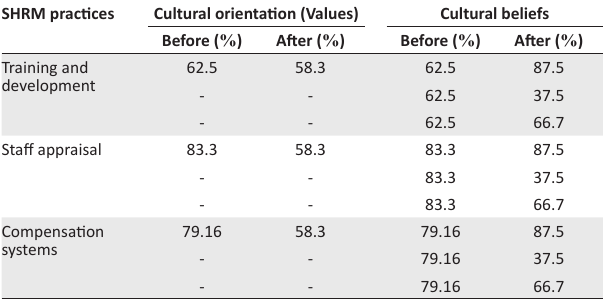
TABLE 7: The moderating influence of cultural orientations on the relationship between SHRM practices and motivation. SHRM